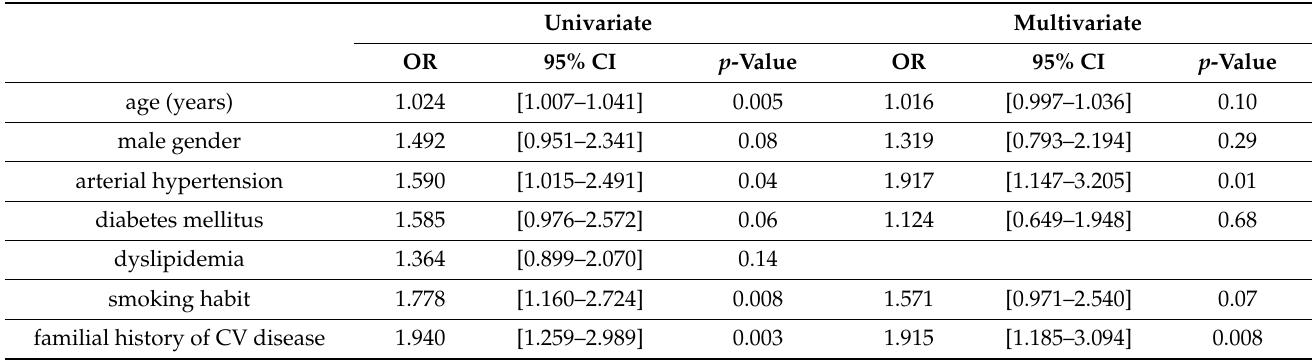
Table 4. Predictive factors of acute coronary syndrome presentation in univariate and multivariate analyses. Beyond the role of traditional cardiovascular risk factors, the allelic variant GT of the nitric oxide synthase 3 gene single-nucleotide polymorphism (SNP) rs1799983 is an independent predictor of acute coronary syndrome